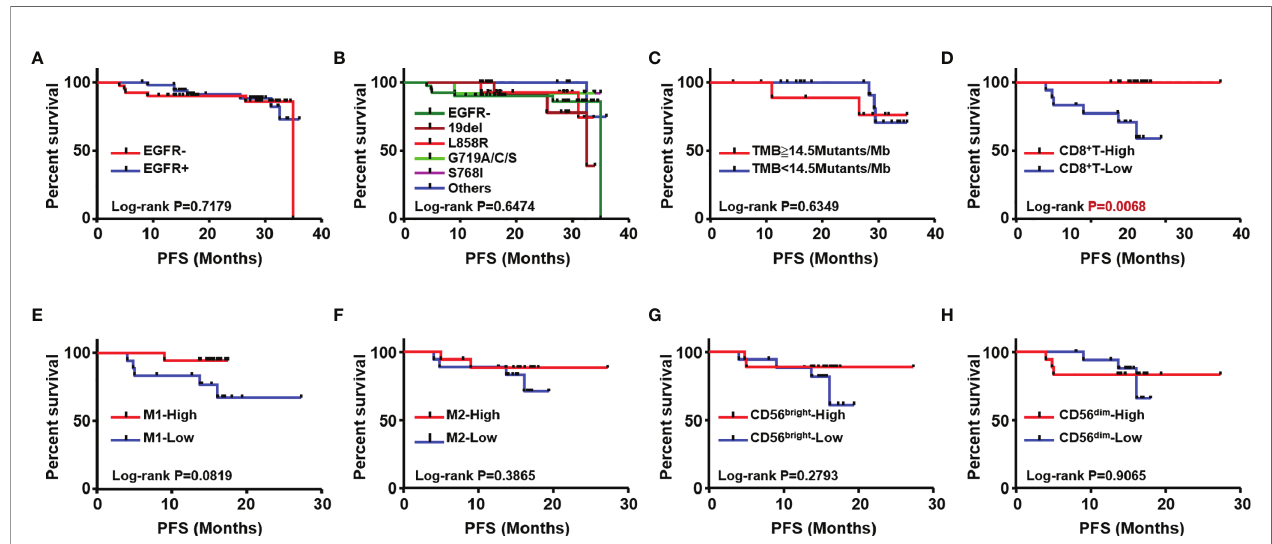
FIGURE 5 | Analysisofassociationwithpatients ’ outcome. KaplanMeierestimatesfor progression-free survival(PFS);patientswerestrati fi edaccordingto with(EGFR+) and withoutEGFR mutation(EGFR-) (A) differentsubtypesofEGFR mutation (B) TMB (C) CD8+T (D) M1 (E) M2macrophages (F) , CD56brightNK (G) andCD56dim NKcells (H)